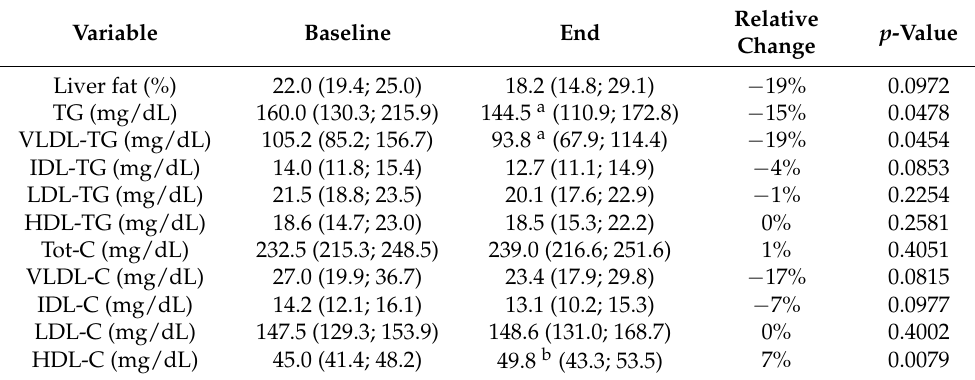
Table 2. Liver and plasma lipid levels’ comparison between baseline and after one year of treatment with sub-micron dispersible phytosterols.